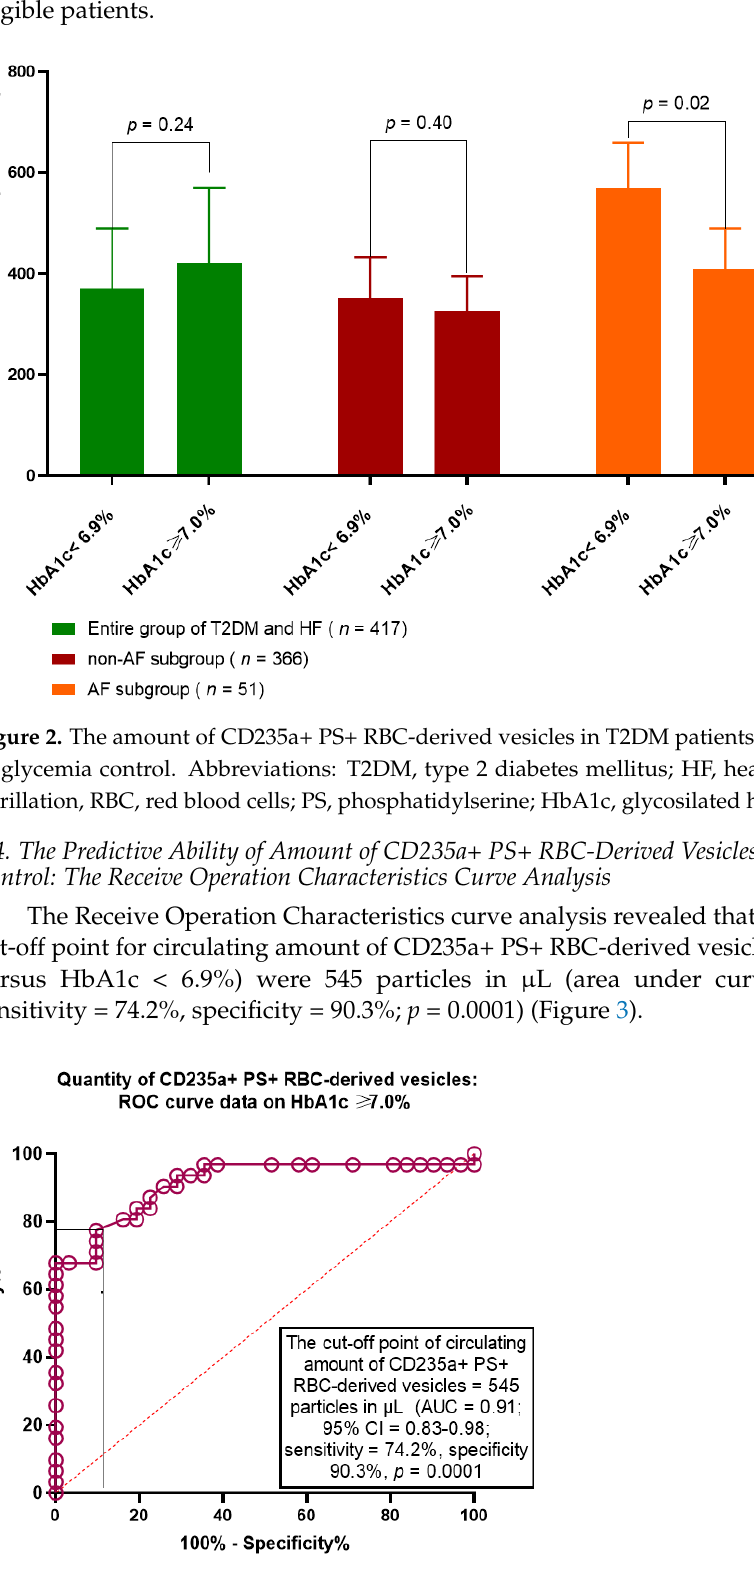
Figure 3. The predictive ability of circulating amount of CD235a+ PS+ RBC-derived vesicles for poor glycaemia control The Receive Operation Characteristics curve analysis. Abbreviations: AUC, area under curve; CI, confidence interval; RBC, red blood cells; PS, phosphatidylserine.